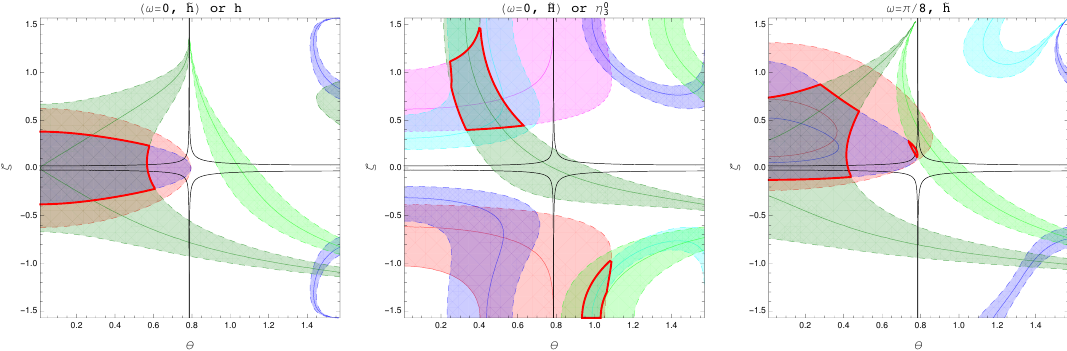
Figure 10 . Regions in the (cid:18) - (cid:16) parameter space with scalar couplings within 30% of the SM value to W + W (cid:0) (red) and ZZ (blue), and within 50% to t (cid:22) t (green). The region in lighter colours (magenta for W + W (cid:0) , cyan for ZZ and light green for t (cid:22) t ) correspond to (cid:13)ipped sign couplings. The red band encircles the areas where al the couplings are within the stated limits. With black lines we show the 3 (cid:27) contours for the (cid:26) parameter, with the allowed region around (cid:16) (cid:25) 0 and (cid:18) (cid:25) (cid:25)= 4. The three panels correspond to di(cid:11)erent choices: ! = 0 for the (cid:12)rst two, which show the couplings for the doublet h (left) and triplet (cid:17) 0 (middle), and ! = (cid:25)= 8 for ~ h 3